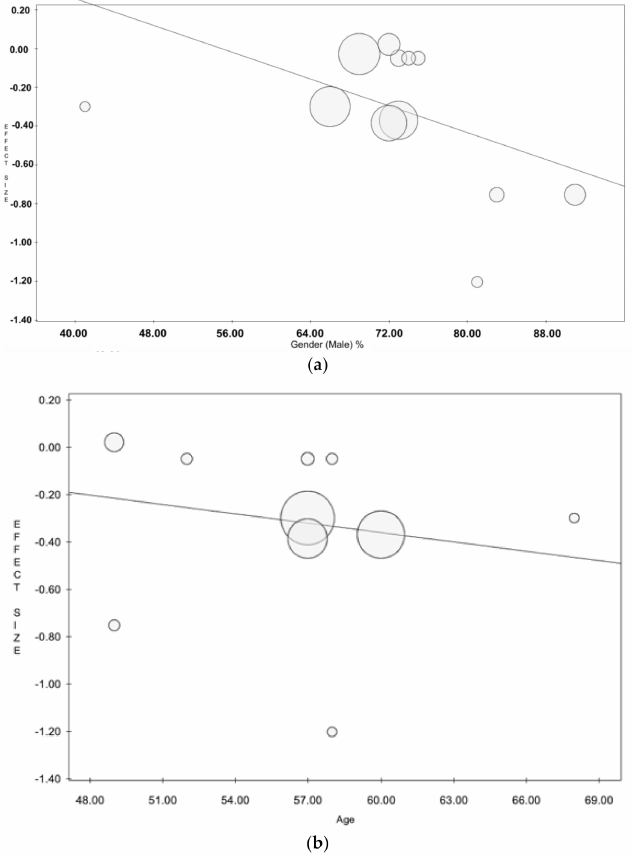
Figure 6. ( a ) Meta-regression analysis plot: effect of male gender. No effect of male gender was reported on long-term survival ( p = 0.092). ( b ) Meta-regression analysis plot: effect of age. No effect of age was reported on long-term survival ( p =